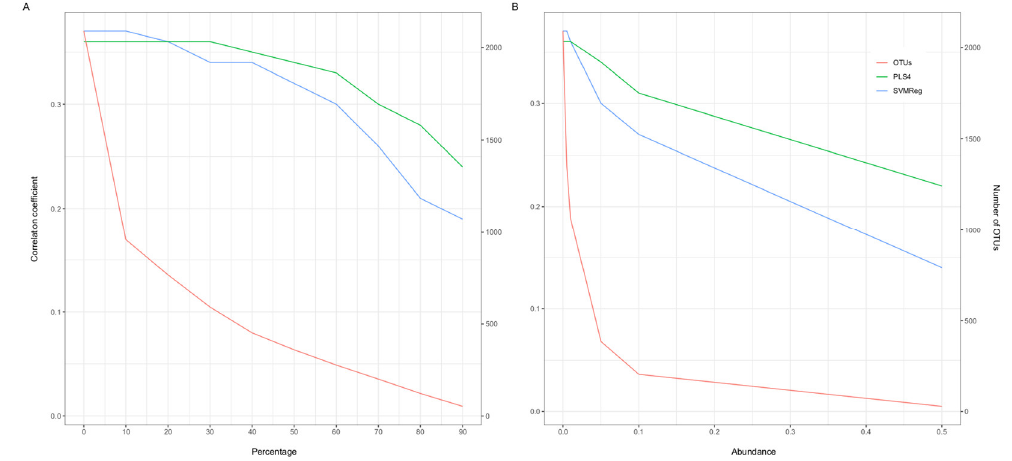
Figure 2. Dependency of prediction capacity on prevalent and abundant OTUs in waist–height ratio, implemented with the combinations SVMReg NPK with CLR, and PLS4 with RA + Log: In each step, ( A ) OTUs present in less than x% of the samples were excluded (prevalence); this means for example in the step 80%, that OTUs with a prevalence of less than 80% were excluded for the calculations. ( B ) OTUs with an across-sample relative abundance of x% or less were excluded (abundance).